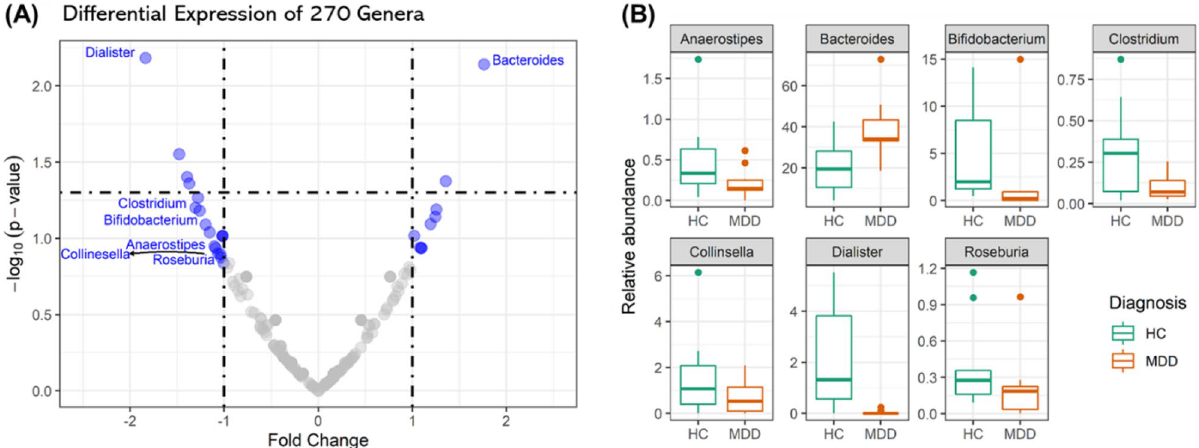
Figure 2. Volcan plot of 270 genera and boxplots of seven genera of interest. ( A ) The volcano plot displays the relationship between fold change (FC) and significance (p-value) between healthy controls and patients with MDD. The x-axis represents the difference in expression between two groups as log2 fold change; the y-axis represents the negative log10 of p-value using the Wilcoxson test. 27 blue dots indicate the absolute values of fold change greater than 1. ( B ) The boxplots depict the relative abundance of the seven genera in each group. These genera have absolute values of FC greater than one and were presented in over 90% of all fecal